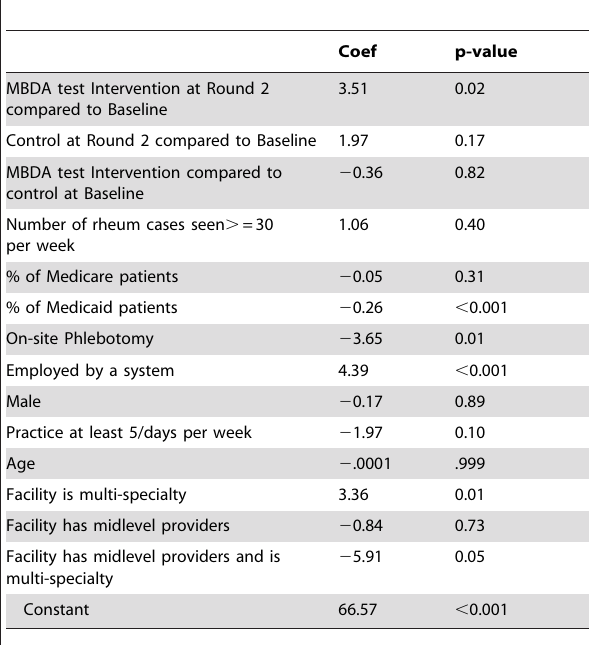
Table 4. Multiple Linear Regression Model of Overall CPV scores for all Case